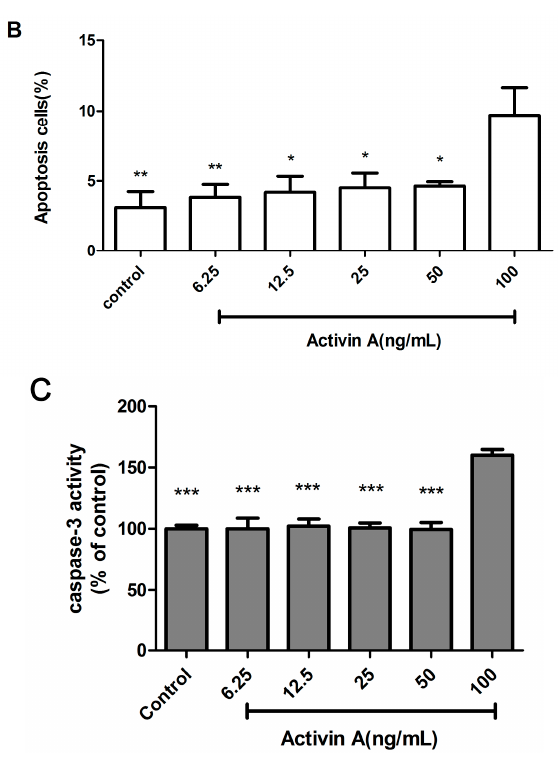
Figure 5. Apoptosis in activin A-stimulated H9c2 cells. ( A ) H9c2 cells were stained with propidium iodide (PI) and Annexin V–fluorescein isothiocyanate (FITC) and sorted by fluorescence-activated flow cytometry. ( a ) control; ( b ) activin A, 6.25 ng/mL; ( c ) activin A, 12.5 ng/mL; ( d ) activin A, 25 ng/mL; ( e ) activin A, 50 ng/mL; and ( f ) activin A, 100 ng/mL; ( B ) Graph presented the percentage of H9c2 cell apoptosis. The data are presented as mean ± standard deviation. * p < 0.05, ** p < 0.01 versus the 100 ng/mL activin A group; ( C ) Caspase-3 activity assay was used to test the relative caspase-3 activity of the control. The data are presented as the mean ± standard deviation. *** p < 0.001 versus the 100 ng/mL activin A group.